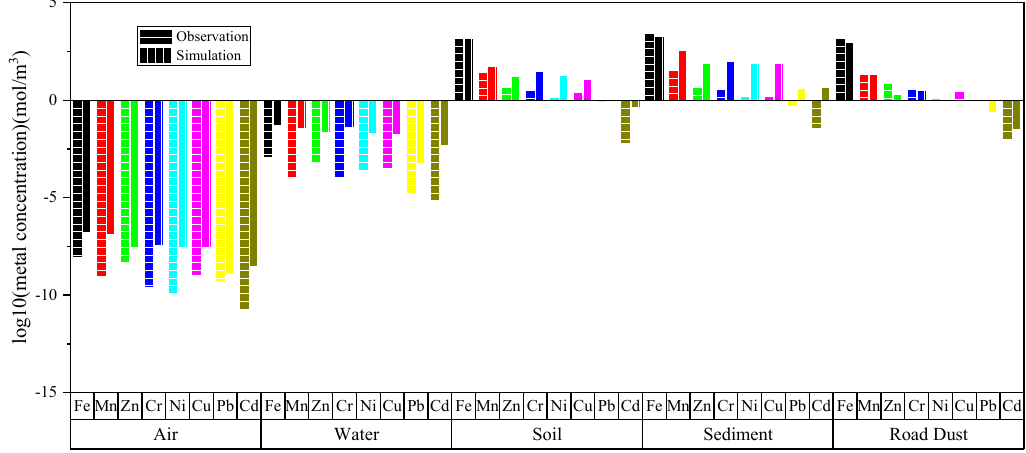
Figure 3. A comparison of the simulated and observed heavy metal concentrations in the compartments .